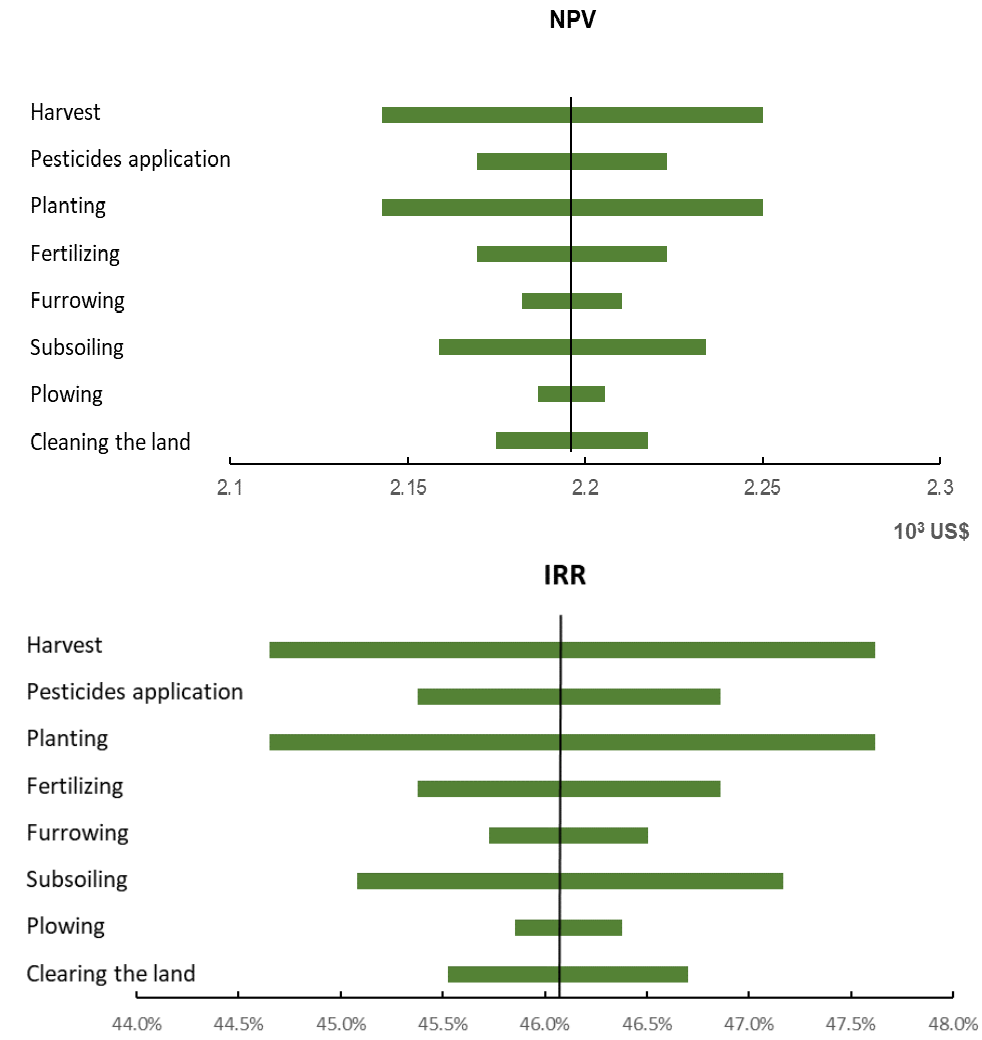
Figure 2. Sensitivity analysis for inputs and processes in cactus production ( Opuntia ficus-indica) in the northeastern semi-arid region of Brazil.